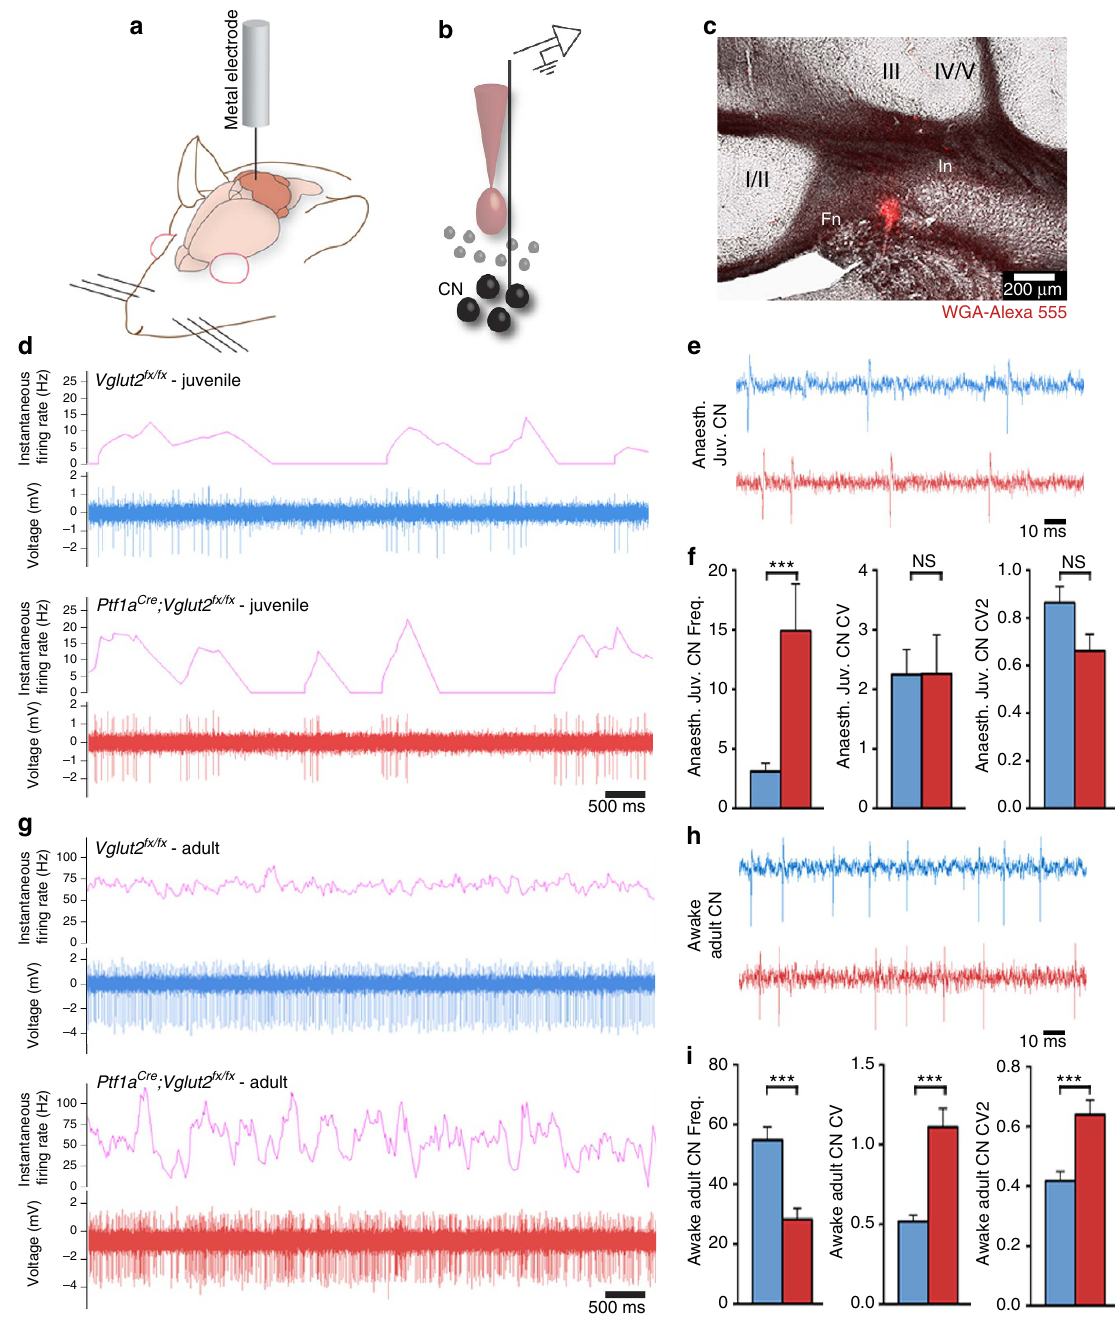
Figure 6 | Cerebellar output function is abnormal in dystonic Ptf1a Cre ;Vglut2 fx/fx mice. ( a ) A schematic example of a single-unit extracellular recording in